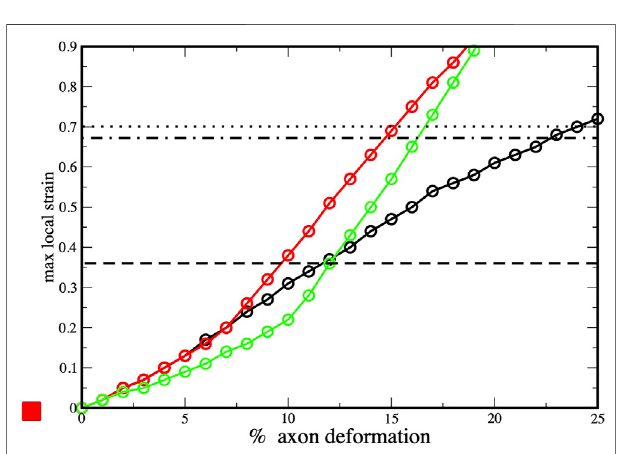
FIGURE 5 | Axonal deformation versus maximum local strains at three strain rates: 1 s − 1 (black), 10 s − 1 (red) and 40 s − 1 (green). Values obtained from fi nite element simulations of axonal stretch (Montanino et al., 2020). The dottedlinecorrespondstorupturestrainobservedformyelinmodel(and dashed-dot lines to the myelin multi-layer model), while the dashed line corresponds the to rupture strain observed for the node-of-Ranvier